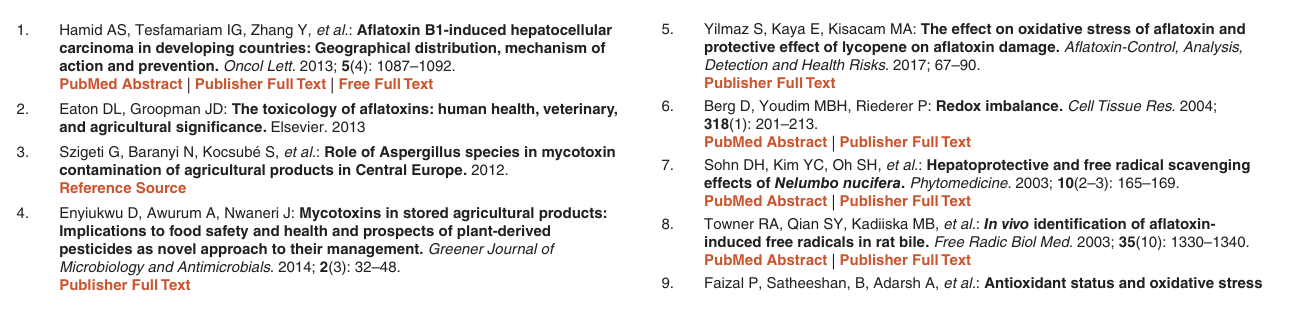
Figshare: Effects of aflatoxin B1 on the submandibular salivary gland of albino rats and possible therapeutic potential of Rosmarinus officinalis: a light and electron microscopic study. https://doi.org/10.6084/m9.figshare.12644855.v2